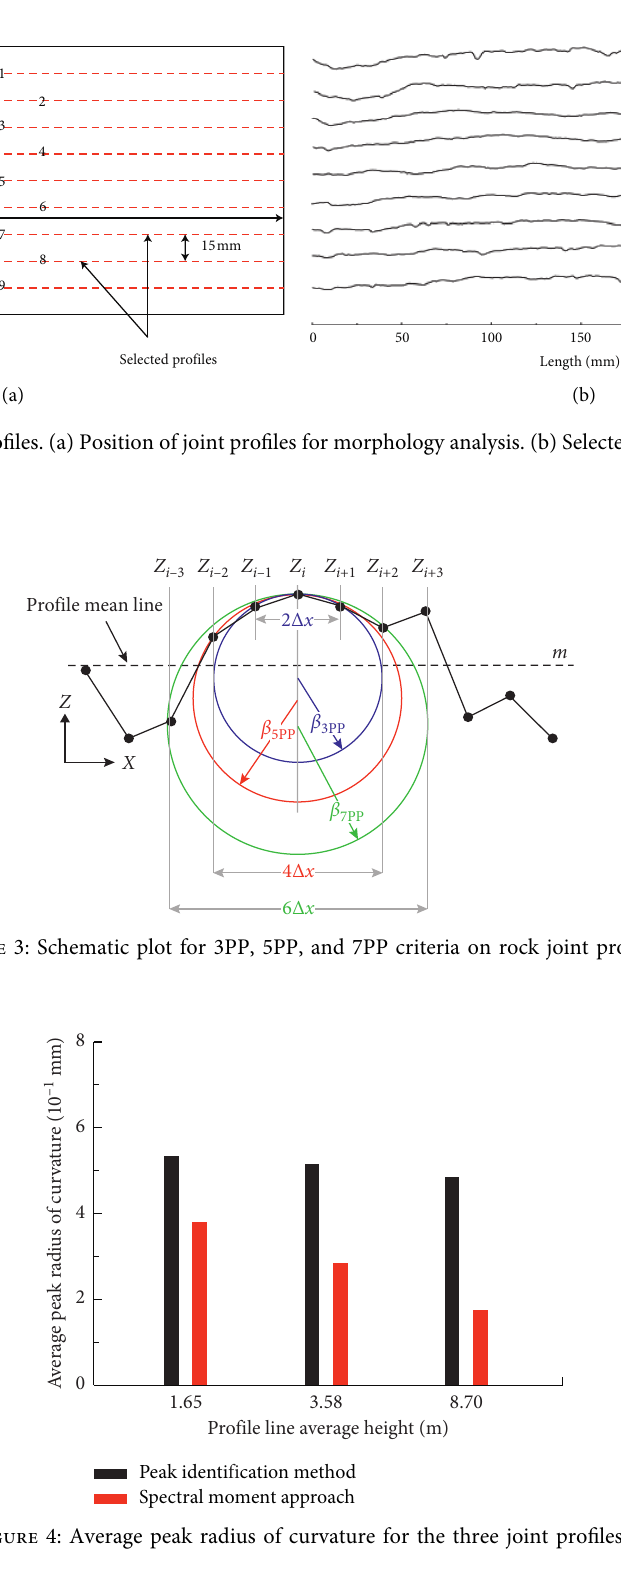
Figure 4: Average peak radius of curvature for the three joint